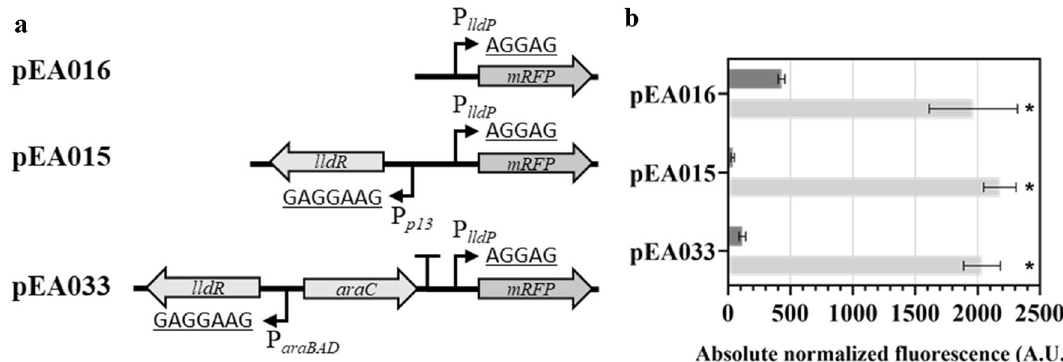
Figure 5. Engineering the L-lactate-inducible system. ( a ) Schematic illustration of the different versions of the Ec LldR/P lldP -inducible system with their corresponding plasmid identifiers and the Shine-Dalgarno sequences are underlined. ( b ) Absolute normalized fluorescence of E. coli DH5α carrying reporter constructs with different versions of the Ec LldR/P lldP -inducible system in the absence (dark grey) and presence (light grey) of 5 mM L-lactate (pEA016 and pEA015). In the case of pEA033, the culture was also supplemented with 0.2% L-arabinose. Single time-point RFP fluorescence measurements were taken 6 h after addition of inducer. Cells were grown in minimal medium containing 0.4% glucose. Error bars represent standard deviations of three biological replicates, * p ≤ 0.01 (unpaired t